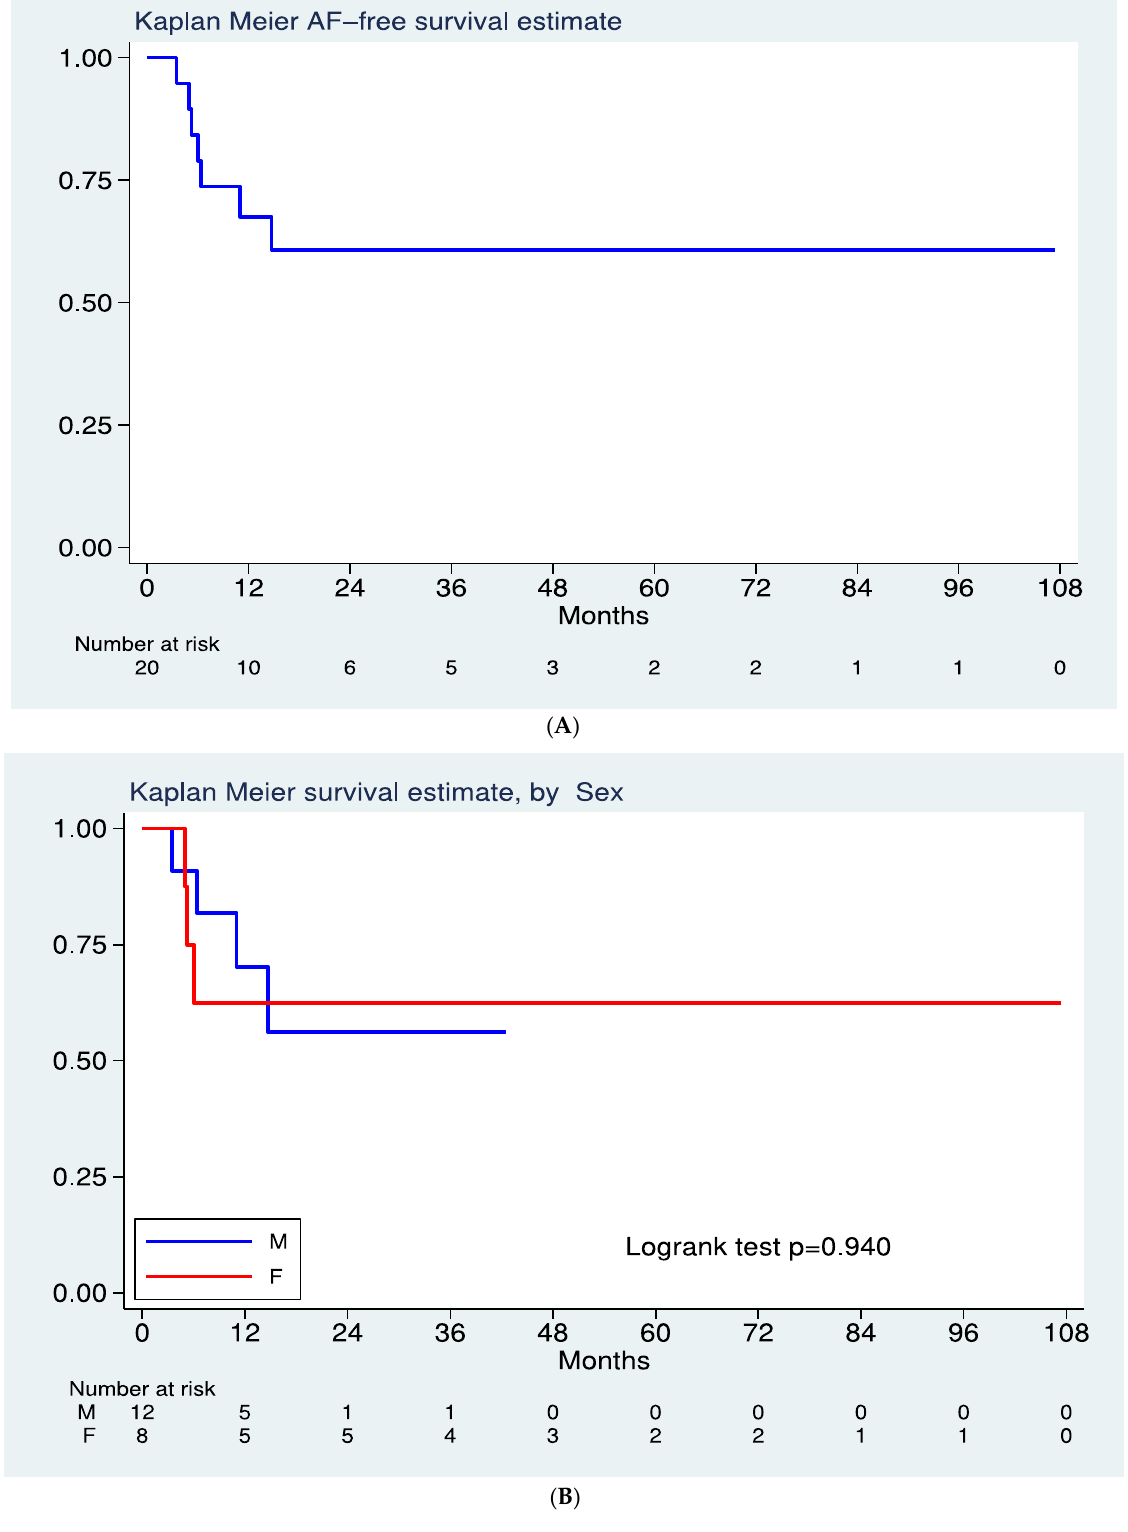
Figure 2. ( A ) Kaplan–Meier curves showing AF recurrence-free survival for follow-up after the blanking period. ( B ) Kaplan–Meier curves showing AF recurrence-free survival for follow-up after the blanking period, after stratification for gender.